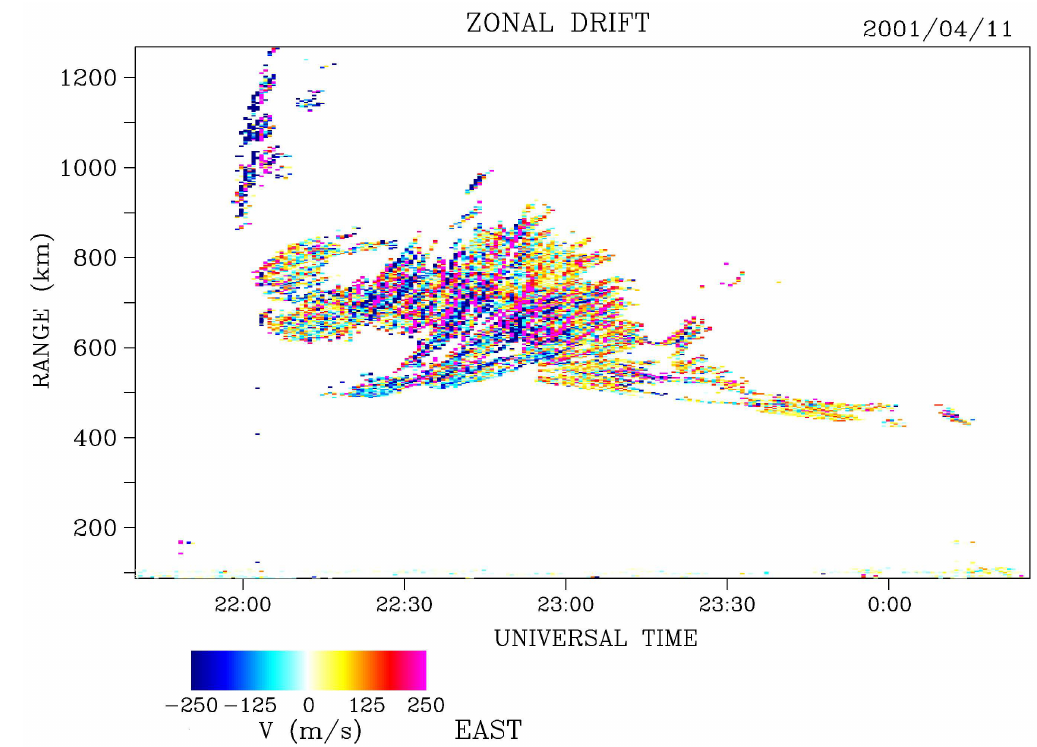
Fig. 3c. VHF radar zonal velocity plot of the echoes from the ionospheric irregularities for the storm night of 11–12 April 2001. Two ionograms, one from 23:00 UT (20:00 LT) during a quiet control night (9–10 April 2001) (upper panel) and